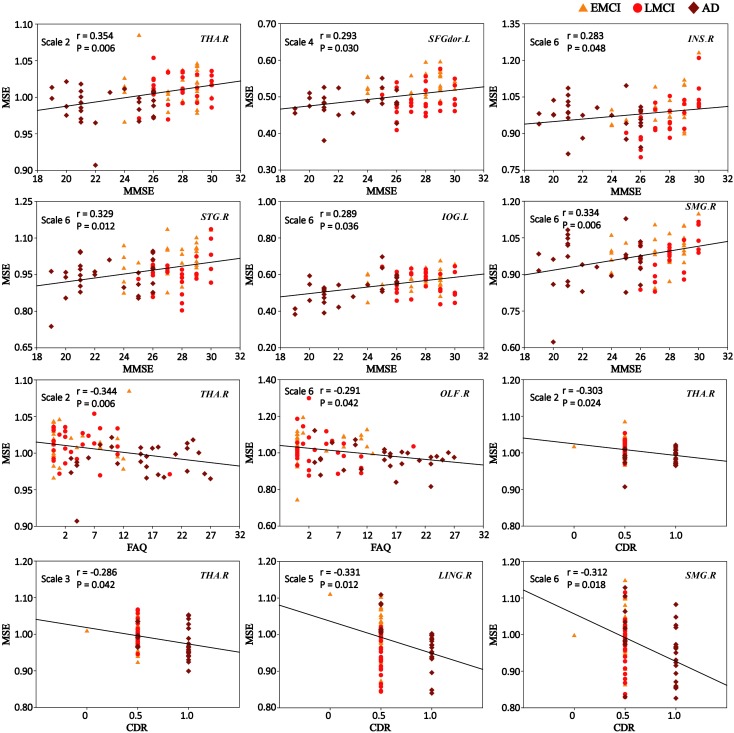
Significant correlations between MSE of blood oxygen level-dependent (BOLD) signals and clinical measurement scores (MMSE, FAQ, and CDR) in patient groups (p < 0.05, corrected). r is the Spearman correlation coefficient, and p indicates the level of statistical significance.